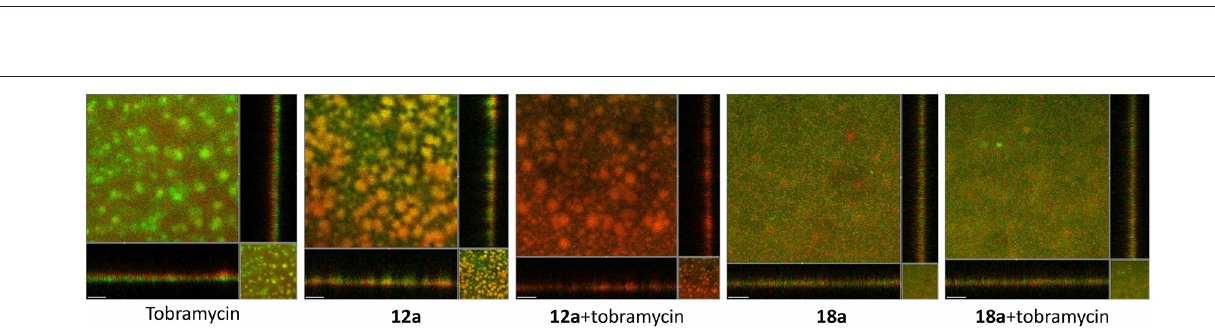
FIGURE 4 | Effects of compounds 12a and 18a on elastase (A) , rhamnolipid (B) , and pyocyanin production (C) . Compounds were tested at final concentration of 10 µ M. All experiments were done in triplicate manner (technical and biological replicates). Error bars are means ± SDs. **** p < 0.0001, Student’s t -test.